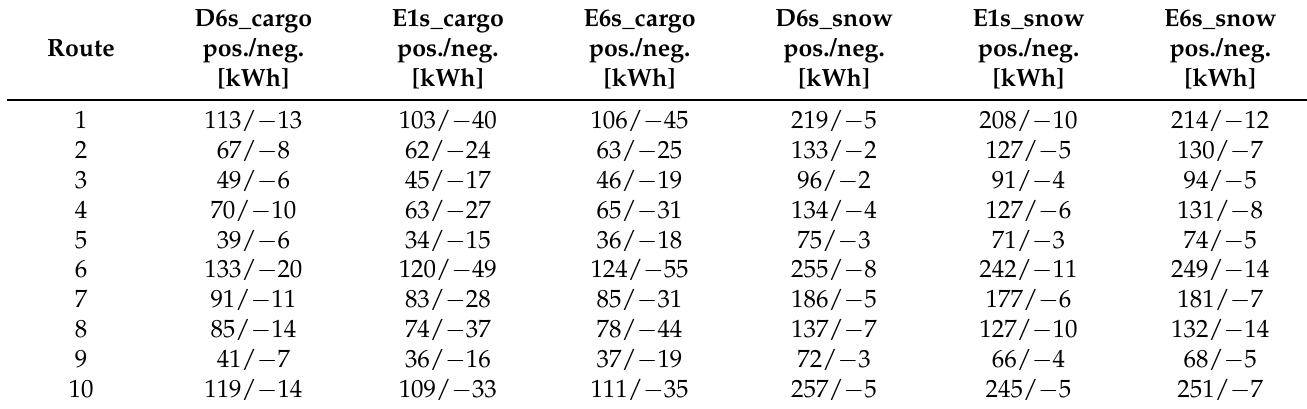
Table 6. The total energy flow between the engine or motor and the transmission calculated through mechanical work. Energy values are divided into positive and negative values. Latter in the diesel case represents engine braking and regenerated braking in electric